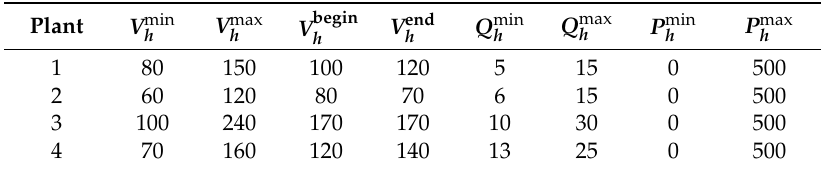
Table A3. Reservoir storage, plant discharge, reservoir end conditions ( × 10 4 m 3 ), and hyro plant generation